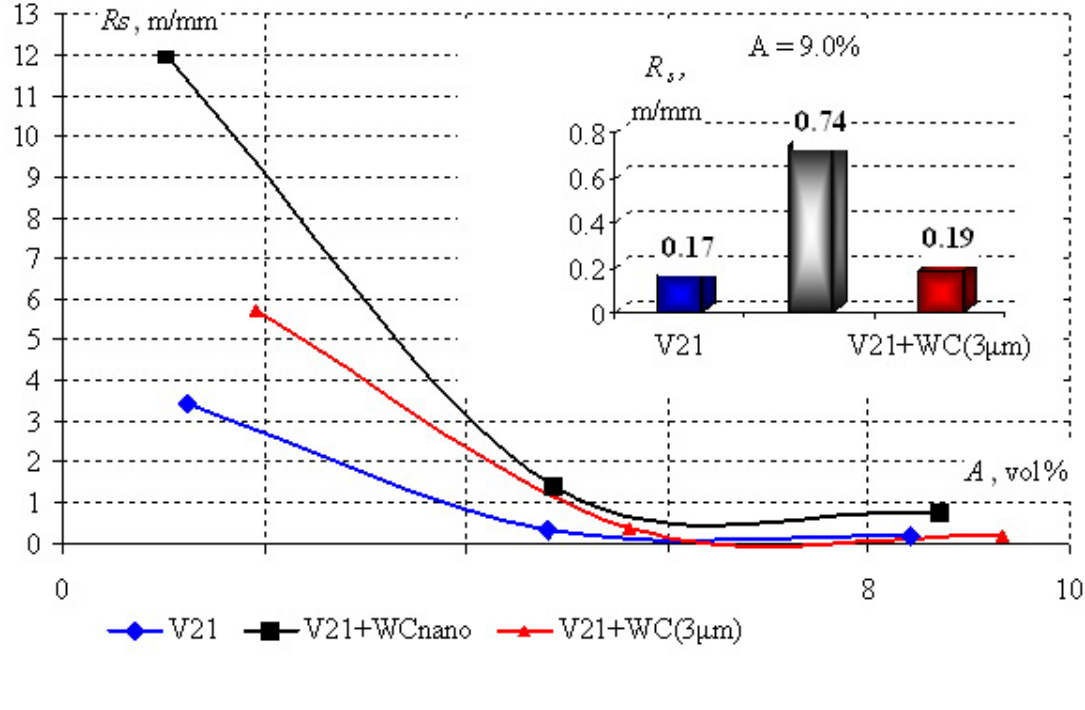
vs . armature content A (vol %) for diamond segments Figure 8. Specific service life R s with a V21 binder dispersion-strengthened with nano- and micro-sized WC